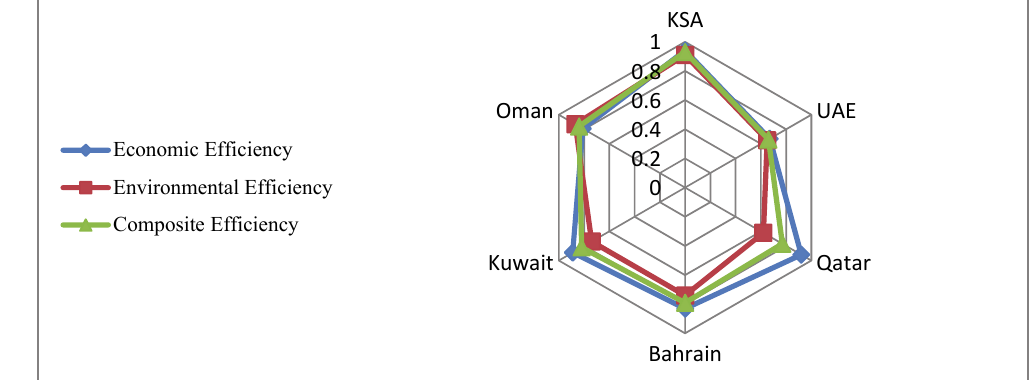
Fig. 1. Composite efficiency of GCC